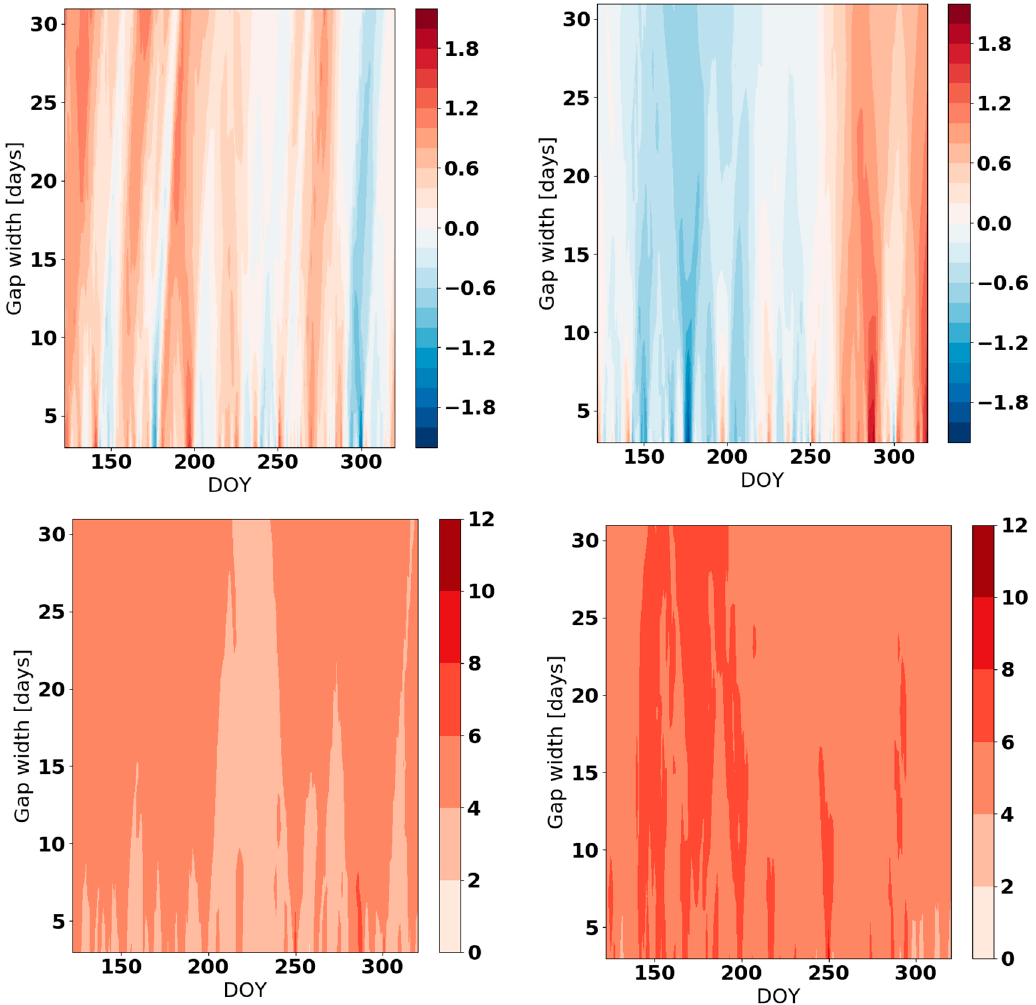
Figure A4. B DEB ( top , left panel ), B ERA5 ( top , right panel ), U(B) DEB ( bottom , left panel ), and U(B) ERA5 ( bottom , right panel ) calculated using data for DOY 122–320 2016 in Montecristo.